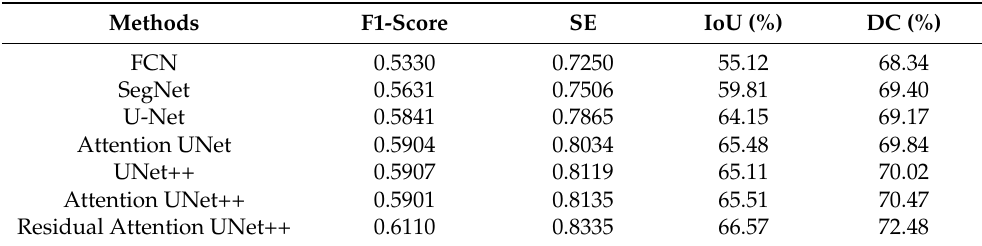
Table 4. Experimental performance of Residual-Attention UNet++ and other methods on Angiogra- phy